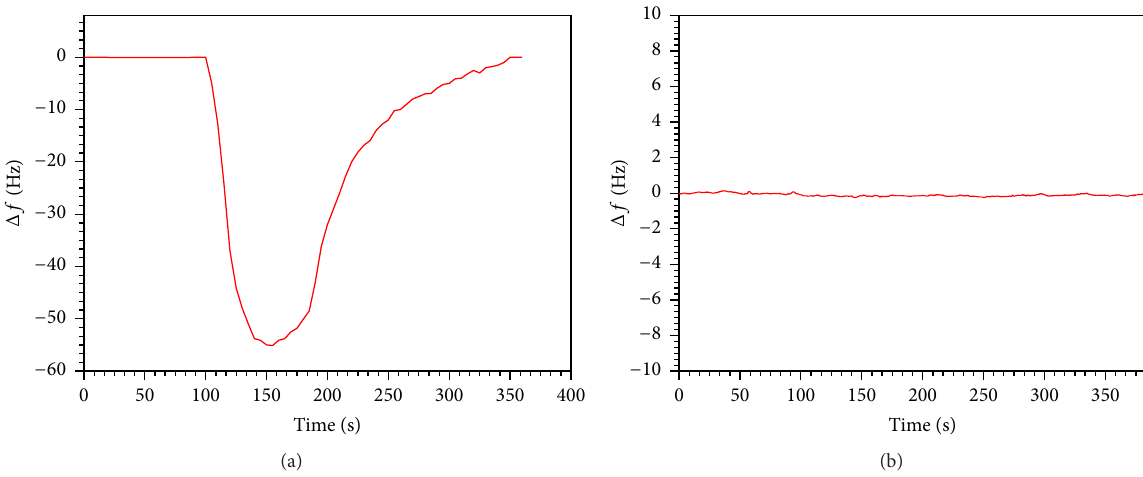
Figure 5: Response to 50 ppm CO of the gas sensor based on PEDOT:PSS/PVP nanofibers (a) and pure PVP nanofibers (b).